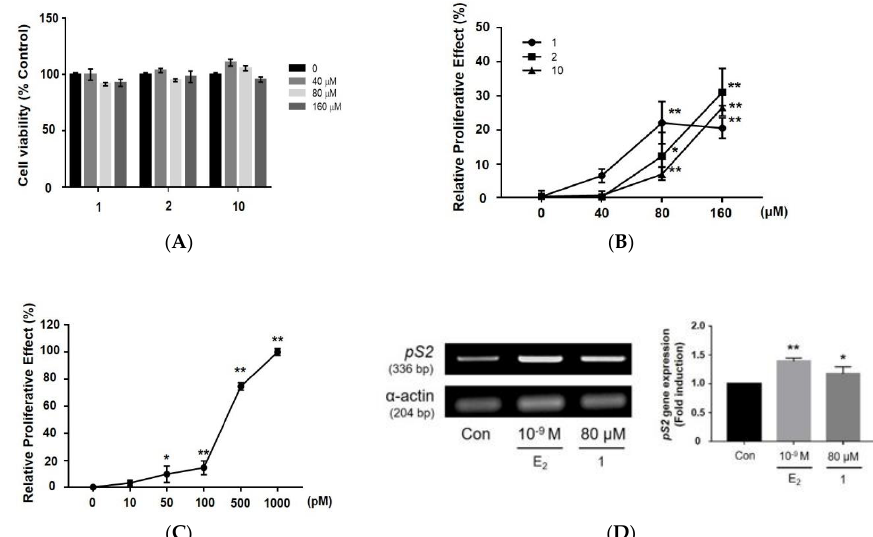
Figure 4. Cytotoxicity and estrogenic effects of compounds 1 , 2 , and 10, isolated from Acer tegmentosum , on MCF-7 BUS cells. ( A ) The effects of the compounds on MCF-7 BUS cell viability were tested by WST-1 assays. Cells were treated with each compound at 20 to 160 µ M for 48 h, and cell viability was quantified with absorbance at 440 nm using a microplate reader. Estrogenic effects of ( B ) compounds (40 to 160 µ M) and ( C ) 17 β -estradiol (E 2 ; 10 -1000 pM) were measured by E-screen assays. Cells were treated with the indicated concentrations of the compounds for 144 h, then sulforhodamine B (SRB) assays were conducted to measure cell proliferation. Cell proliferation relative to that in the presence of E 2 (10 − 9 M; 1000 pM, 100%) was represented as the relative proliferative effect and expressed as mean ± SD of three separate experiments for each group. ( D ) Effects of compound 1 on pS2 mRNA expression. Cells were treated with compound 1 for 48 h, then total mRNA was extracted using RNAiso Plus reagent. pS2 mRNA levels were measured by RT-PCR and normalized using α -actin mRNA as an internal standard. Symbols (*, **) represent statistical differences from the vehicle control (Con, 0.1% DMSO): * p < 0.05, ** p <